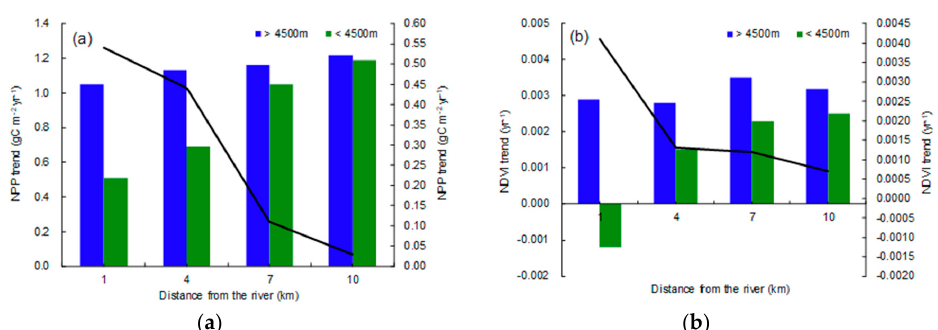
Figure 7. Comparison of vegetation variation trends at different distances from the riverway under altitude gradients: ( a ) NPP and ( b ) NDVI. Polyline represents the difference in variation trend (the right-side Y axis) caused by altitude level.